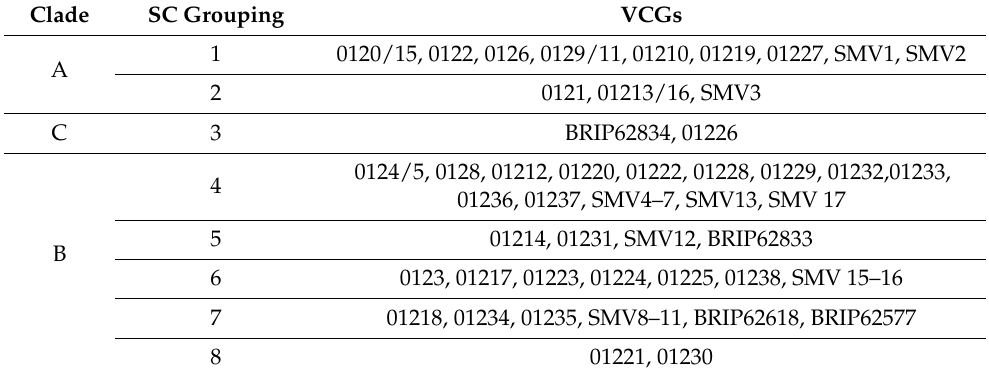
Table 1. Summary of phylogenetic clades and Snapclust grouping among different Fusarium oxyspo- rum f. sp. cubense vegetative compatibility